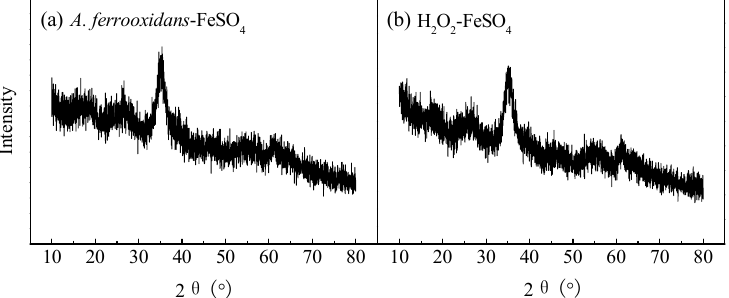
Figure 2. XRD patterns of ( a ) biologically and ( b ) chemically synthesized schwertmannite at 28 °C and 180 rpm for 72 h. Experimental conditions: initial pH = 3.0; FeSO 4 ·7H 2 O dosage 11.12 g; A. ferrooxidans density 6.0 × 10 6 cell·mL −1 ; H 2 O 2 volume 6 mL.